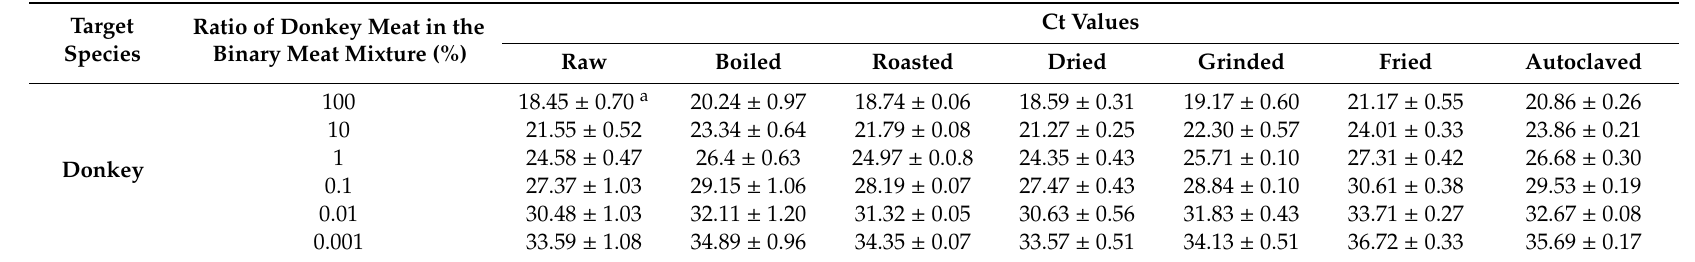
Table 3. Results of the developed real time-PCR method when applied to six meat mixtures processed following di ff erent technologies. Target Species Boiled Roasted Dried Grinded Fried Autoclaved